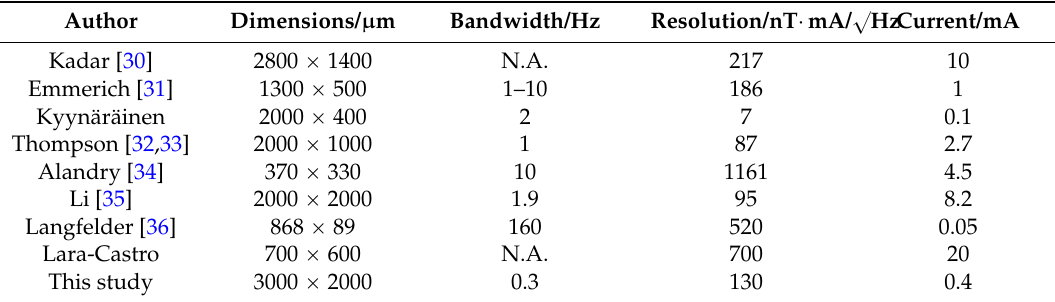
Table 1. Comparison of magnetic field sensing system performance.